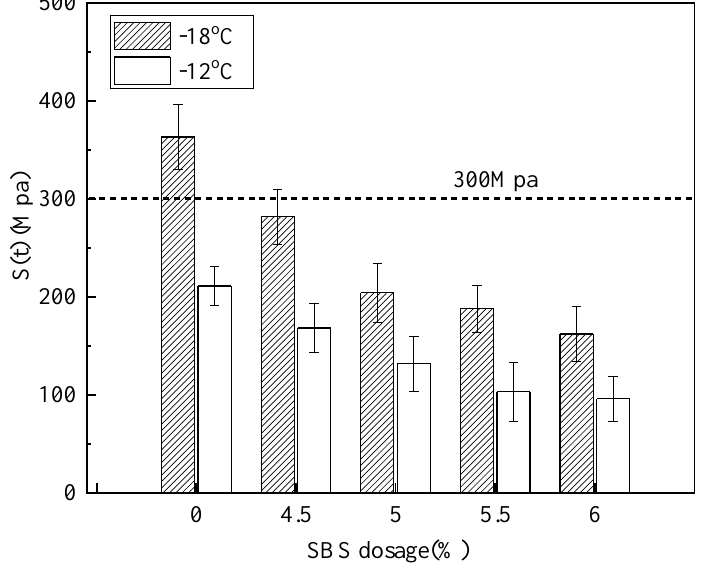
Figure 6. Creep stiffness S(t) of SK90# matrix asphalt and SBS modified asphalt.